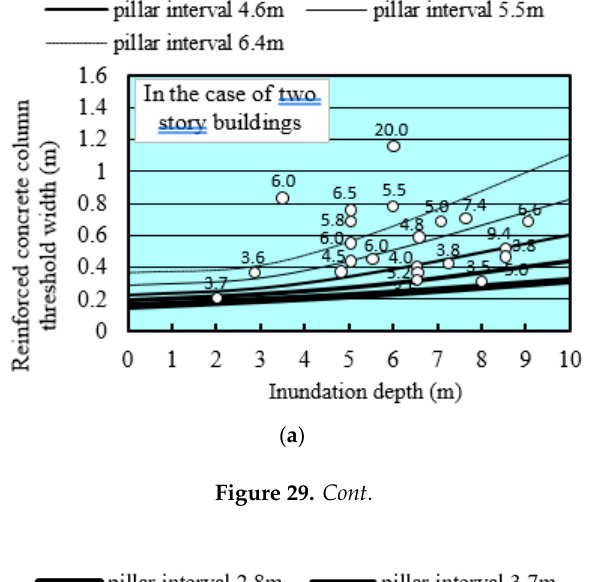
J. Mar. Sci. Eng. 2020 , 8 , 762